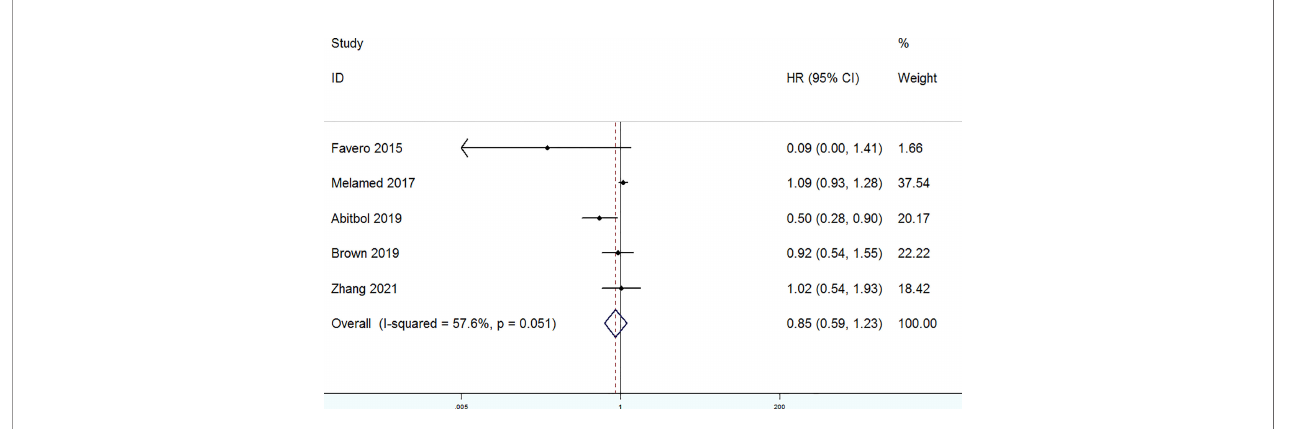
FIGURE 2 | Forest plots for overall survival (OS).